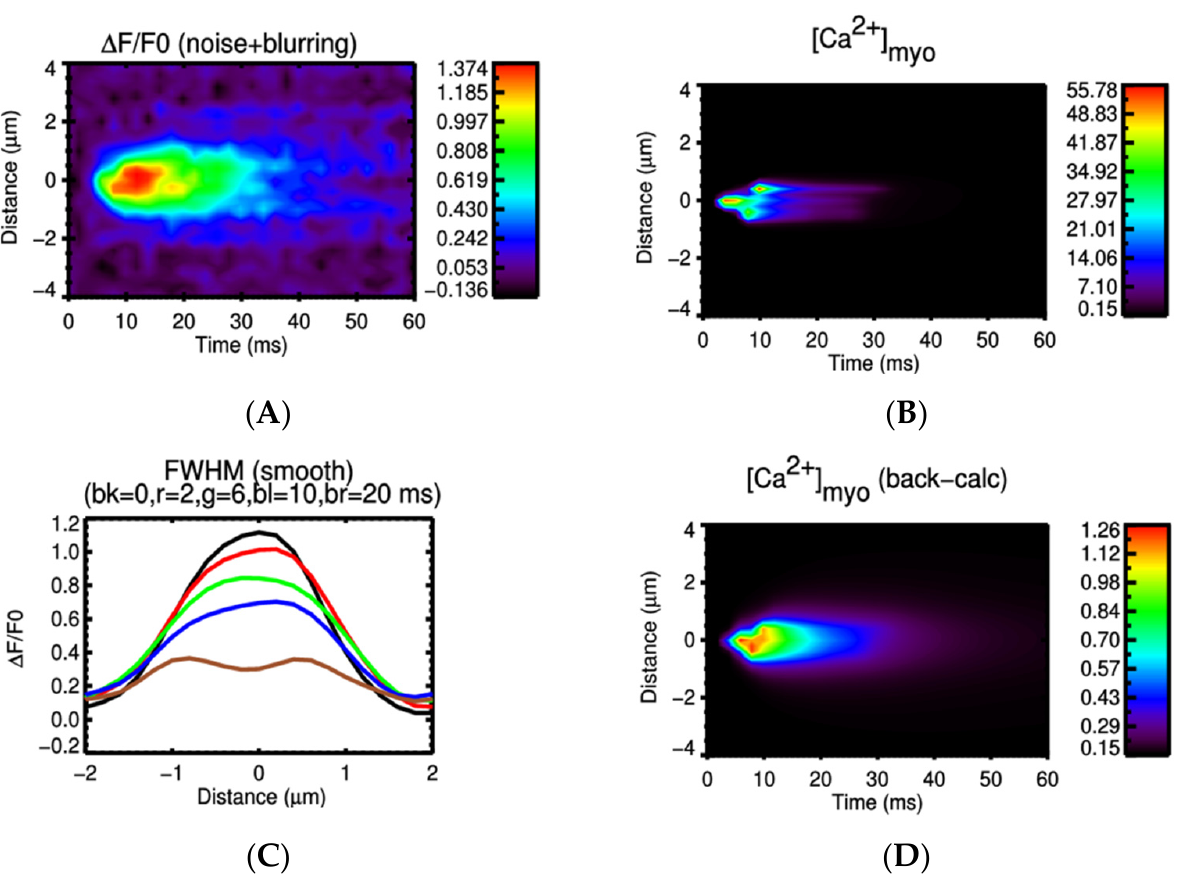
suggested that blocking small, non-spark producing clusters of RyR2 using ruthenium red (RuR) are important to the process of Ca 2+ wave propagation.